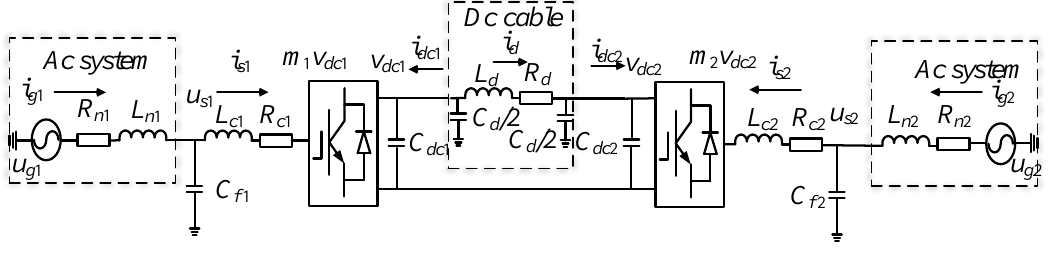
Figure 1. VSC–HVDC used in AC grid interconnection. Figure 1. VSC – HVDC used in AC grid interconnection.